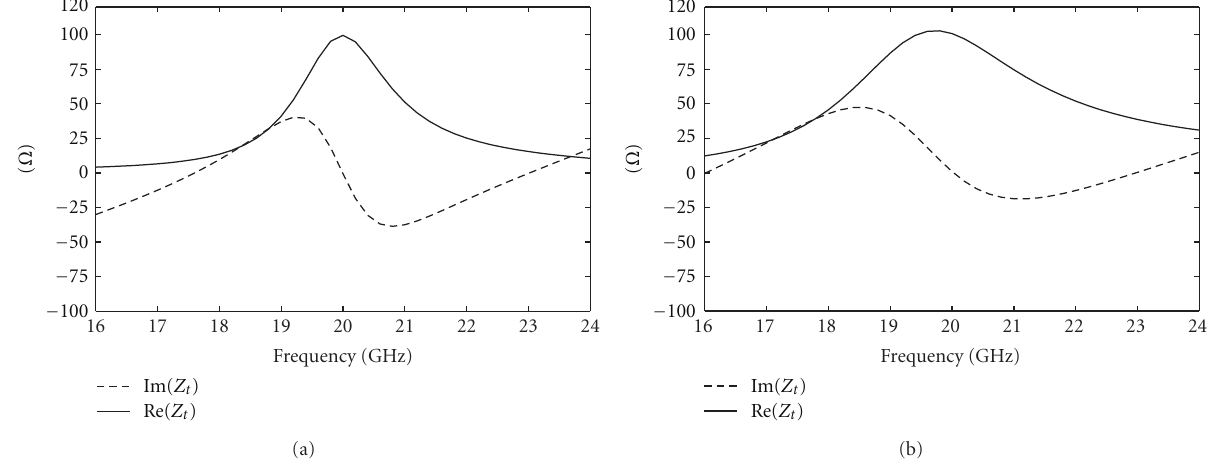
to exactly compensate the phase delay (2) in a rather wide neighborhood of f 0